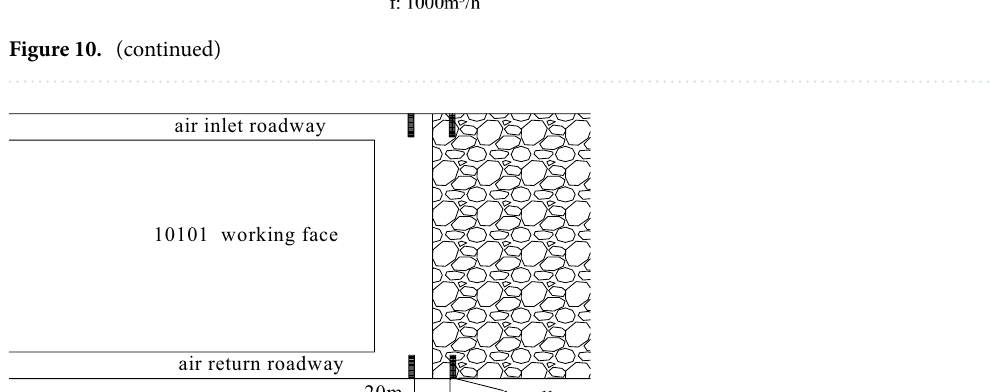
Figure 11. 10,101 fully mechanized top coal caving face goaf seal wall layout